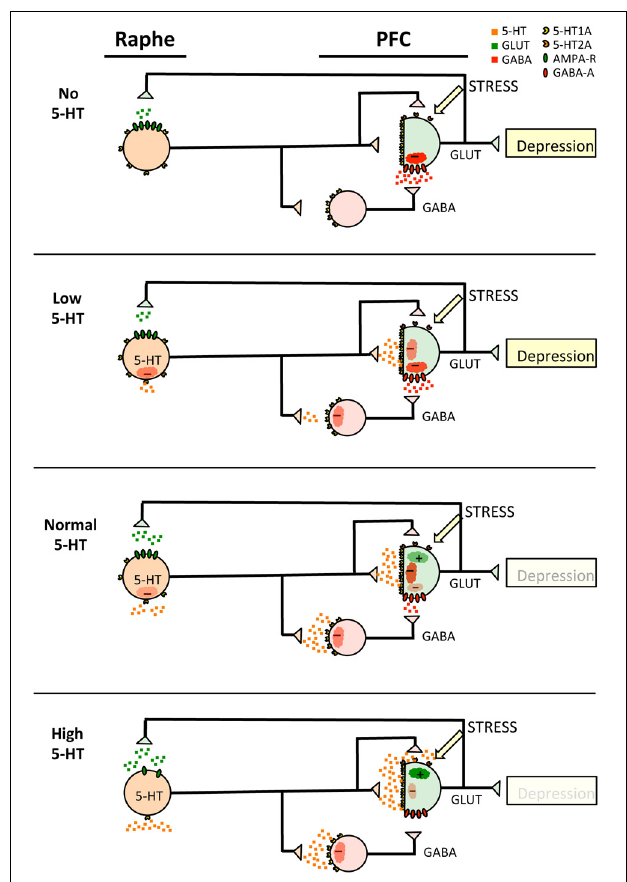
FIGURE 2 | Adult 5-HT-PFC circuitry in depression models. Shown are the components of the Raphe 5-HT-PFC circuit in adult animals with no, low, normal or high levels of 5-HT neurotransmission as indicated. The model shows 5-HT neurons (orange) projecting to prefrontal cortex GABAergic interneurons (red) and glutamatergic pyramidal neurons (green) with transmitter release illustrated as small squares of the same colors. The presence of 5-HT1A (yellow), 5-HT2A (orange), AMPA-glutamate (green) and GABA-A receptors (red) is shown, as well as the response in the target neurons (clouds), stimulatory ( + ) or inhibitory ( − ). The effect of stress to stimulate pyramidal output is also indicated. It is postulated that 5-HT1A-mediated inhibition in adulthood becomes predominant in pyramidal neurons compared to interneurons, and that reduced activity of target pyramidal neurons elicits depression during